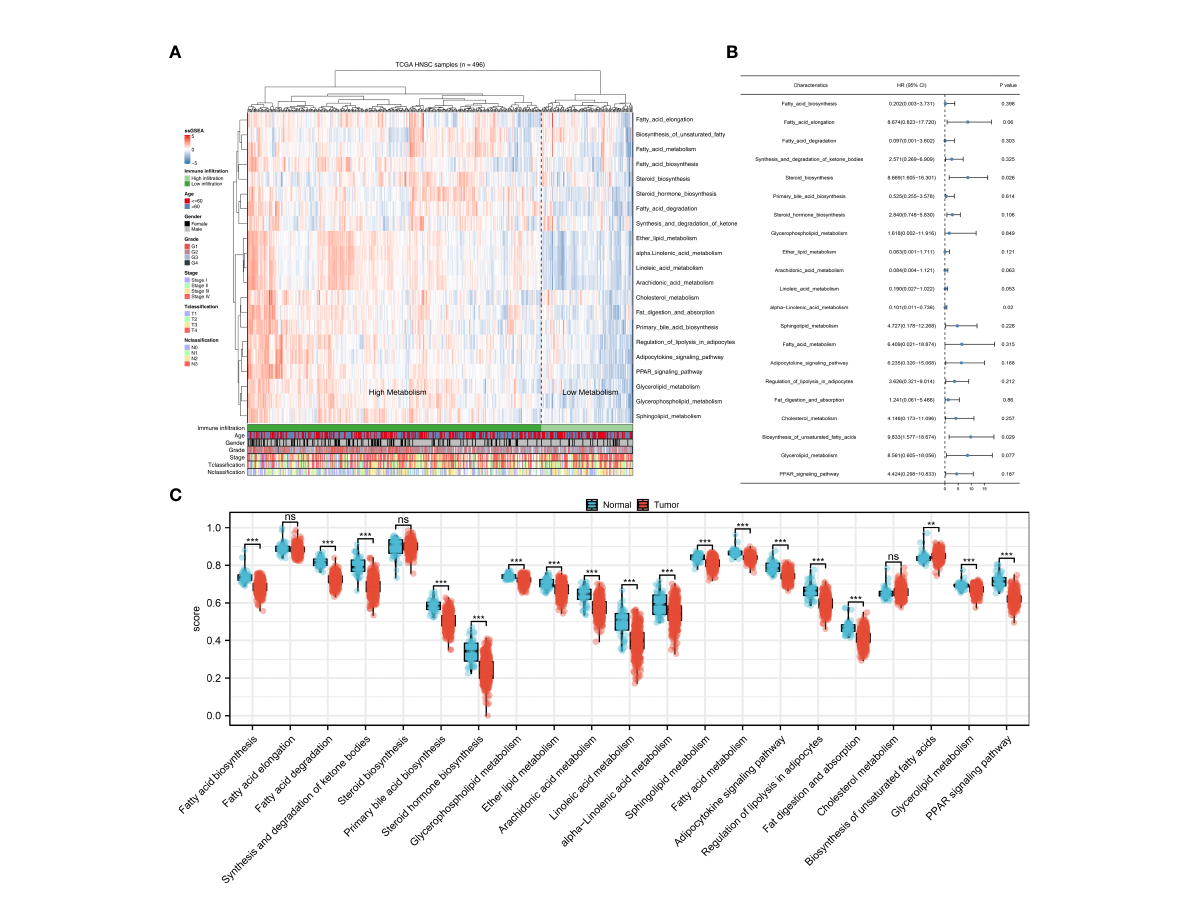
FIGURE 1 Quanti fi cation of the metabolism pathways. (A) ssGSEA algorithm was used to quantify the 21 metabolism pathways; (B) Univariate Cox analysis was used to identify the prognosis-related metabolism pathways; (C) The 21 metabolism pathways difference in normal and tumor tissue. **P < 0.01; ***P < 0.001; ns, P >